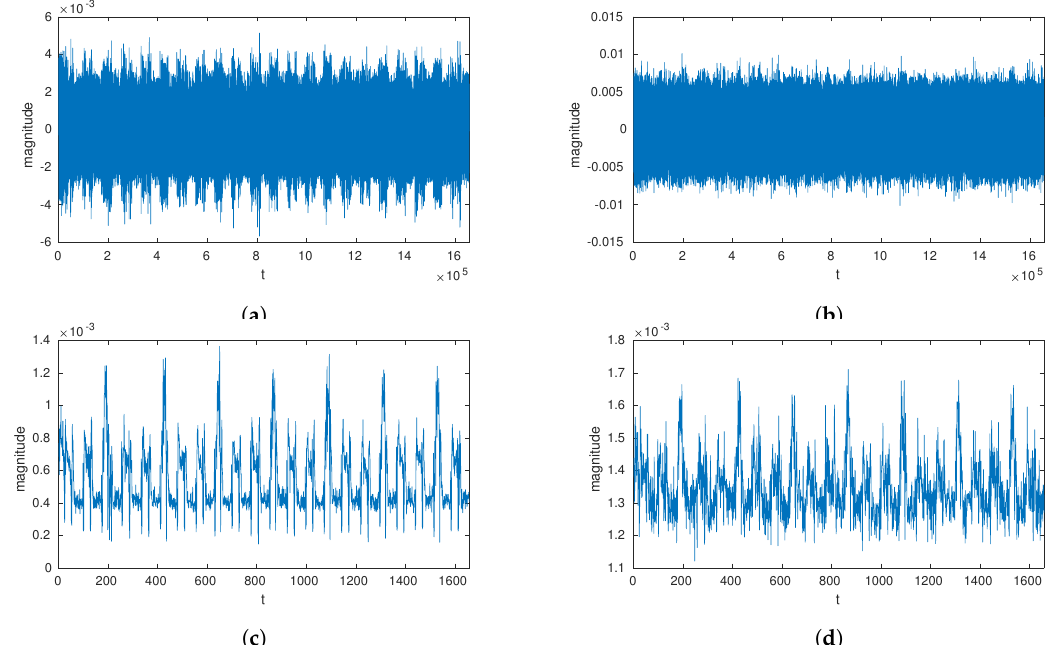
Figure 2. Raw and noise-added power traces preprocessing with median sampling. ( a ) Power trace; ( b ) Noise-added trace; ( c ) Median-sampled power trace; ( d ) Noise-added and median-sampled power